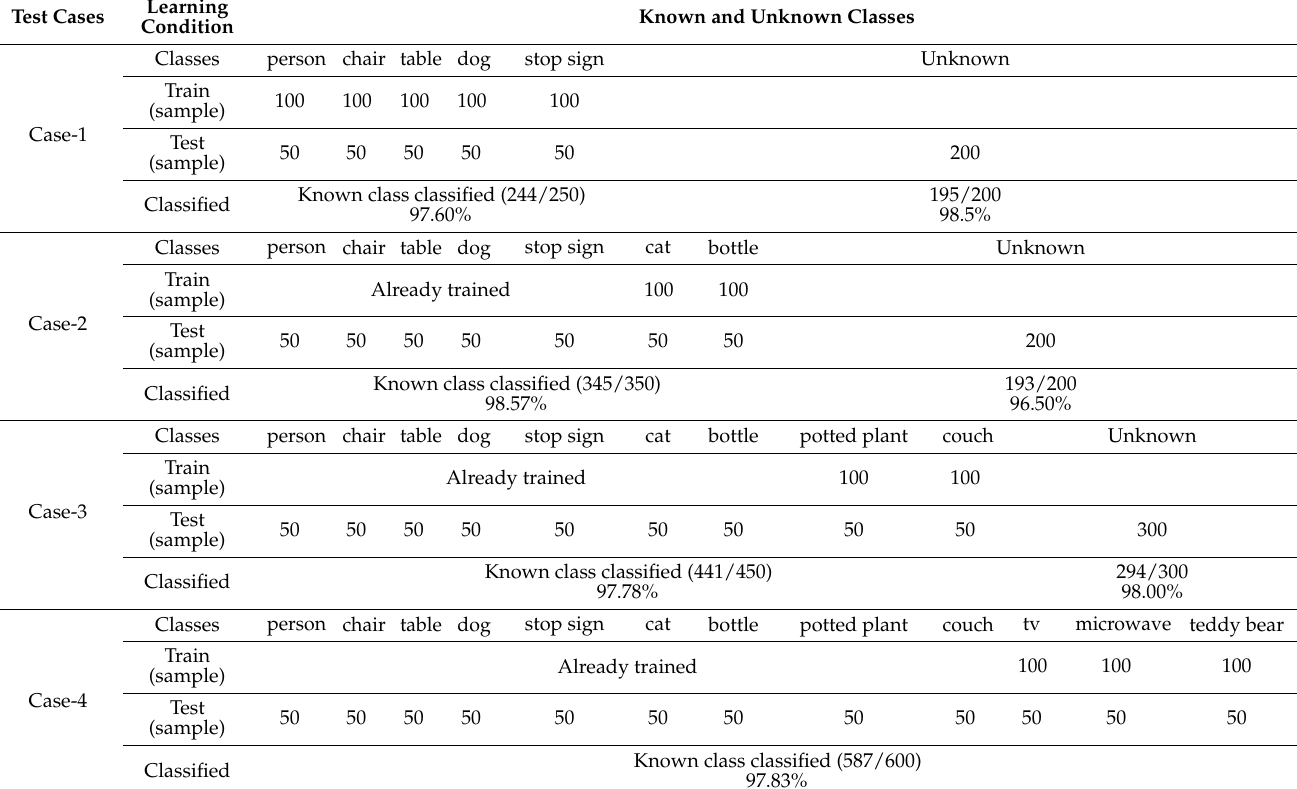
Table 2. Results and performance for each test case during implementation of one-class SVM and incremental learning. Table 3. Sample detection outcome for test cases 1 and 2 (where 1 = known and 0 = unknown).